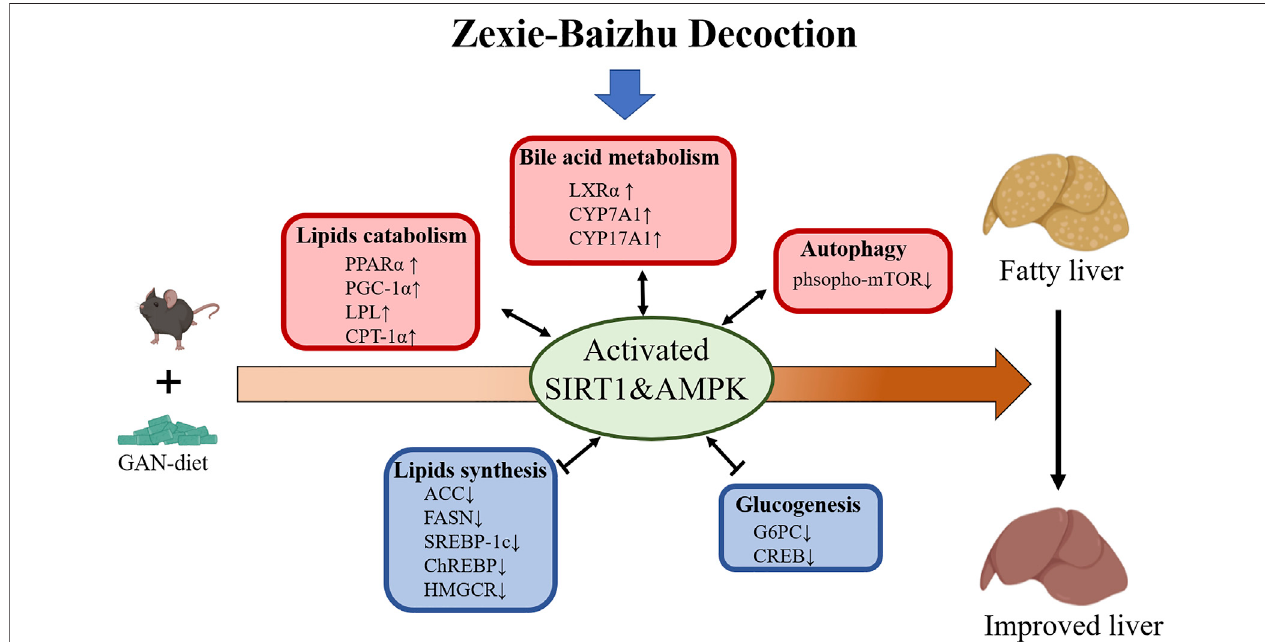
FIGURE 8| Proposed mechanism model for ZXBZ decoction treatment in NAFLD mice. GAN diet – induced lipid disorders in mice. ZXBZ decoction activated Sirt1 andAMPK,subsequentlyin fl uencedrelated genestoimprovelipidmetabolism. Thelipogenesis(SREBP-1c, ChREBP,ACC,FAS,andHMGCR)weresuppressed,fatty utilization (PPAR α , PGC-1 α , LPL, CPT-1 α ) were activated, bile acid metabolism (LXR α , CYPs) were increased, gluconeogenesis (Creb, G6pc) was inhibited, and autophagy (mTOR) was prompted. As a result, the livers were protected from